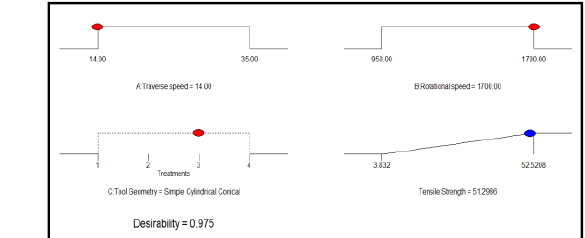
Fig. 15: Optimization in terms of Ramps Response